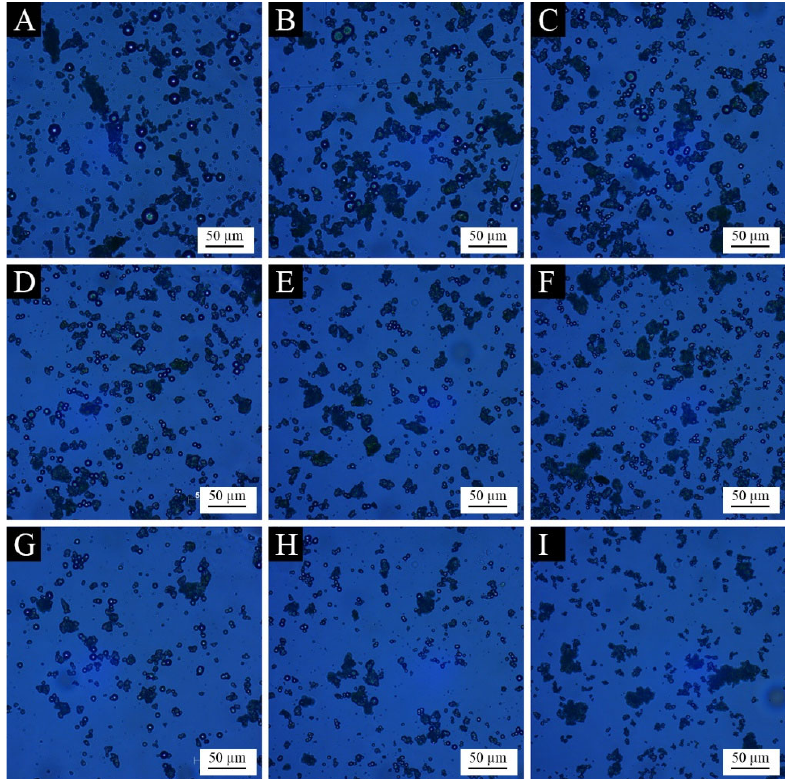
Figure 5. OM images of microcapsules in the single factor experiment: ( A ) sample 10, ( B ) sample 11, ( C ) sample 12, ( D ) sample 13, ( E ) sample 14, ( F ) sample 15, ( G ) sample 16, ( H ) sample 17, and ( I ) sample 18.